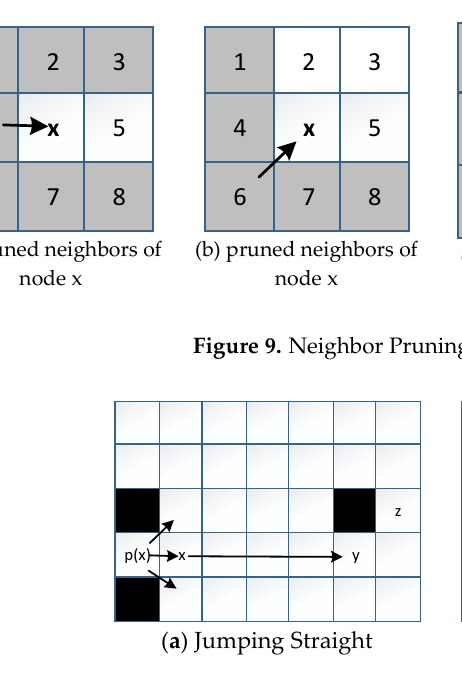
Figure 10. Successful straight and diagonal jumps with the JPS algorithm by applying pruning and forced neighbor rules.